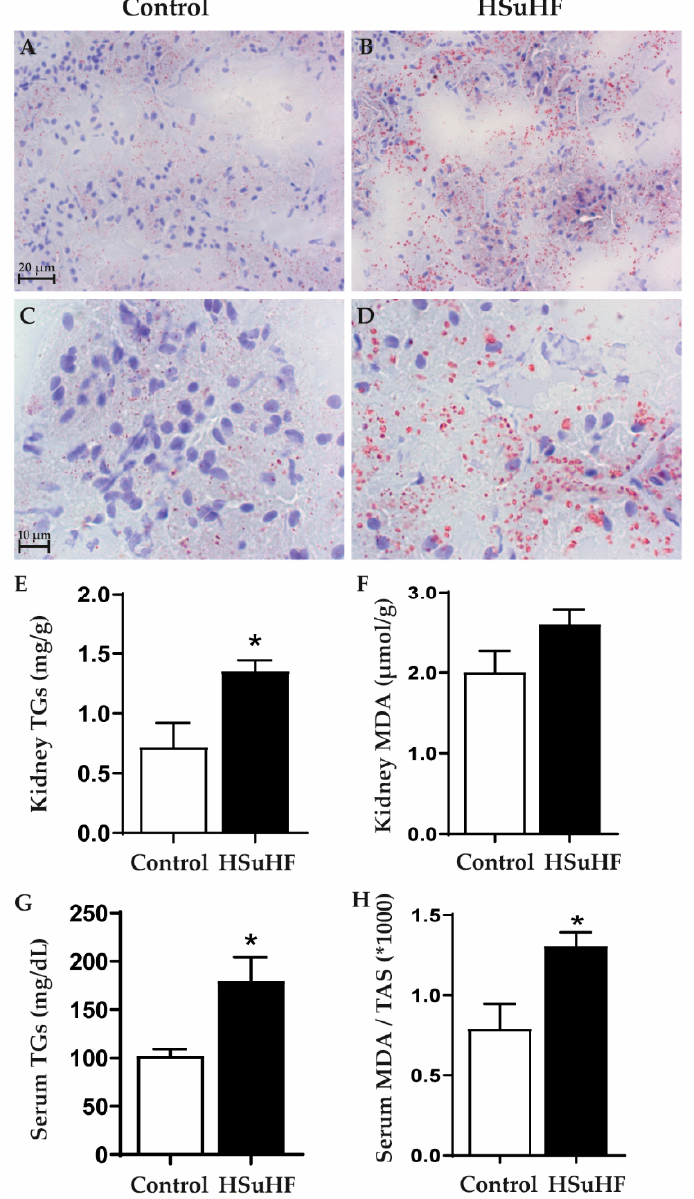
Figure 5. Renal lipid deposition evaluated by Oil-Red O staining in the Control (A–B) and HSuHF- Figure5. RenallipiddepositionevaluatedbyOil-RedOstainingintheControl( A , B )andHSuHF-treated treated (C–D) rats; kidney TGs concentration (E) and MDA content (F); serum TGs concentration (G) ( C , D ) rats; kidney TGs concentration ( E ) and MDA content ( F ); serum TGs concentration ( G ) and MDA / TAS ratio ( H ). Values are means ± S.E.M. of n = 8 per group. * P < 0.05. A and C are 40 × amplification and B and D 100 ×